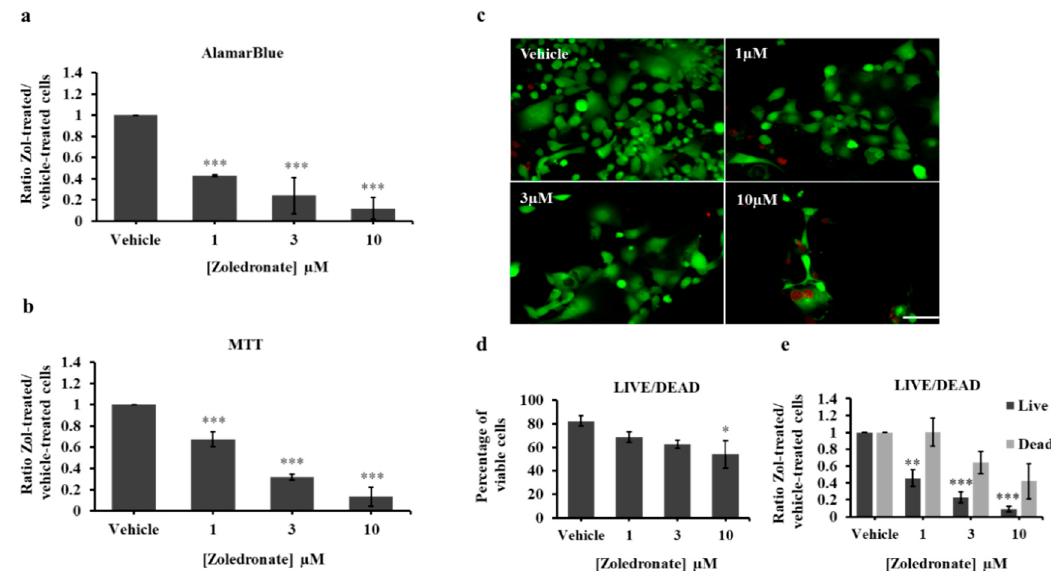
Figure 2. AlamarBlue ( a ) and MTT ( b ) assays of HCC827 cells treated with vehicle (PBS1x) or Zol 1 µM, 3µM and 10 µM for 7 days in 1% serum conditions. The histograms in (a) and (b) represent the ratio of drug-treated cells divided by vehicle-treated cells (PBS1x) in three independent experiments. ( c ) representative photos of Live/Dead assay carried out on HCC827 following vehicle or Zol treatment at different concentrations. Live cells are in green and dead cells are in red. Scale bar 250 µm. ( d ) Percentage of viable cells [number of live cells/(number of live cells + number of dead cells) × 100]. ( e ) ratio of live cells or dead cells in vehicle or Zol-treated conditions. Significantly different from control * p < 0.05, ** p < 0.01 and *** p < 0.001.